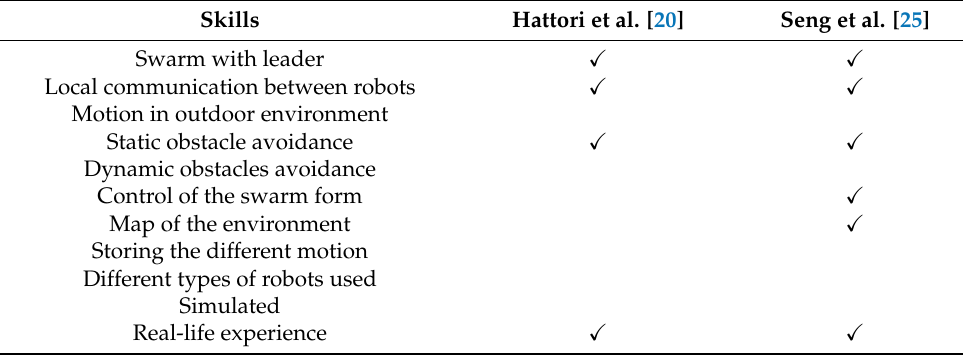
Table 6. Comparison of the different algorithms for decentralized and distributed swarm. Skills Hattori et al. [20] Seng et al. [25] Swarm with leader Local communication between